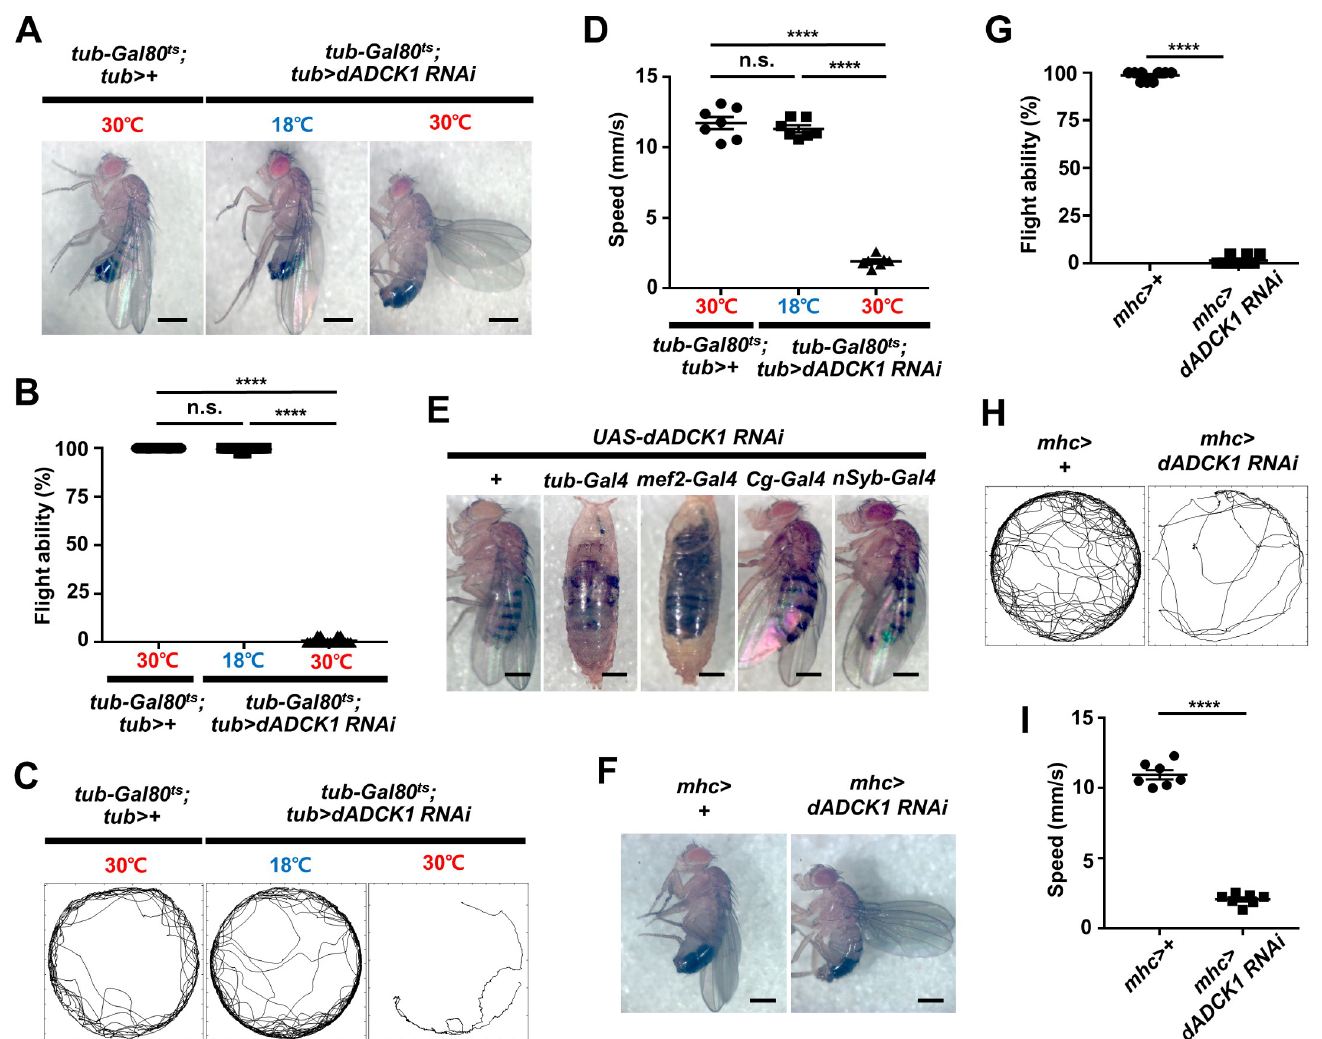
Fig 2. ADCK1 knockdown causes abnormality in locomotive activity. (A) Whole body images of the adult flies with indicated genotypes raised at noted temperatures. Scale bars, 0.5 mm. (B) Comparison of the flight ability for the flies with indicated genotypes. n = 20. ���� , p < 0.0001; n.s., not significant by unpaired t-test. (C) Movement trajectories of the adult flies with indicated genotypes and raised temperatures. (D) Comparison of the means of walking speed for the flies with indicated genotypes, n = 7. ���� , p < 0.0001; n.s., not significant by unpaired t-test. (E) Whole body images of the flies with indicated genotypes. dADCK1 knockdown using ubiquitous tub-Gal4 driver, muscle-specific mef2-Gal4 driver, fat body-specific Cg-Gal4 driver, and neuron-specific nSyb-Gal4 driver. Scale bars, 0.5 mm. (F) Whole body images of the adult flies with indicated genotypes. Scale bars, 0.5 mm. (G) Comparison of the flight ability for the flies with indicated genotypes. n = 10. ���� , p < 0.0001 by unpaired t-test. (H) Movement trajectories of the adult flies with indicated genotypes. (I) Comparison of the means of walking speed for the flies with indicated genotypes, n = 7. ���� , p < 0.0001 by unpaired